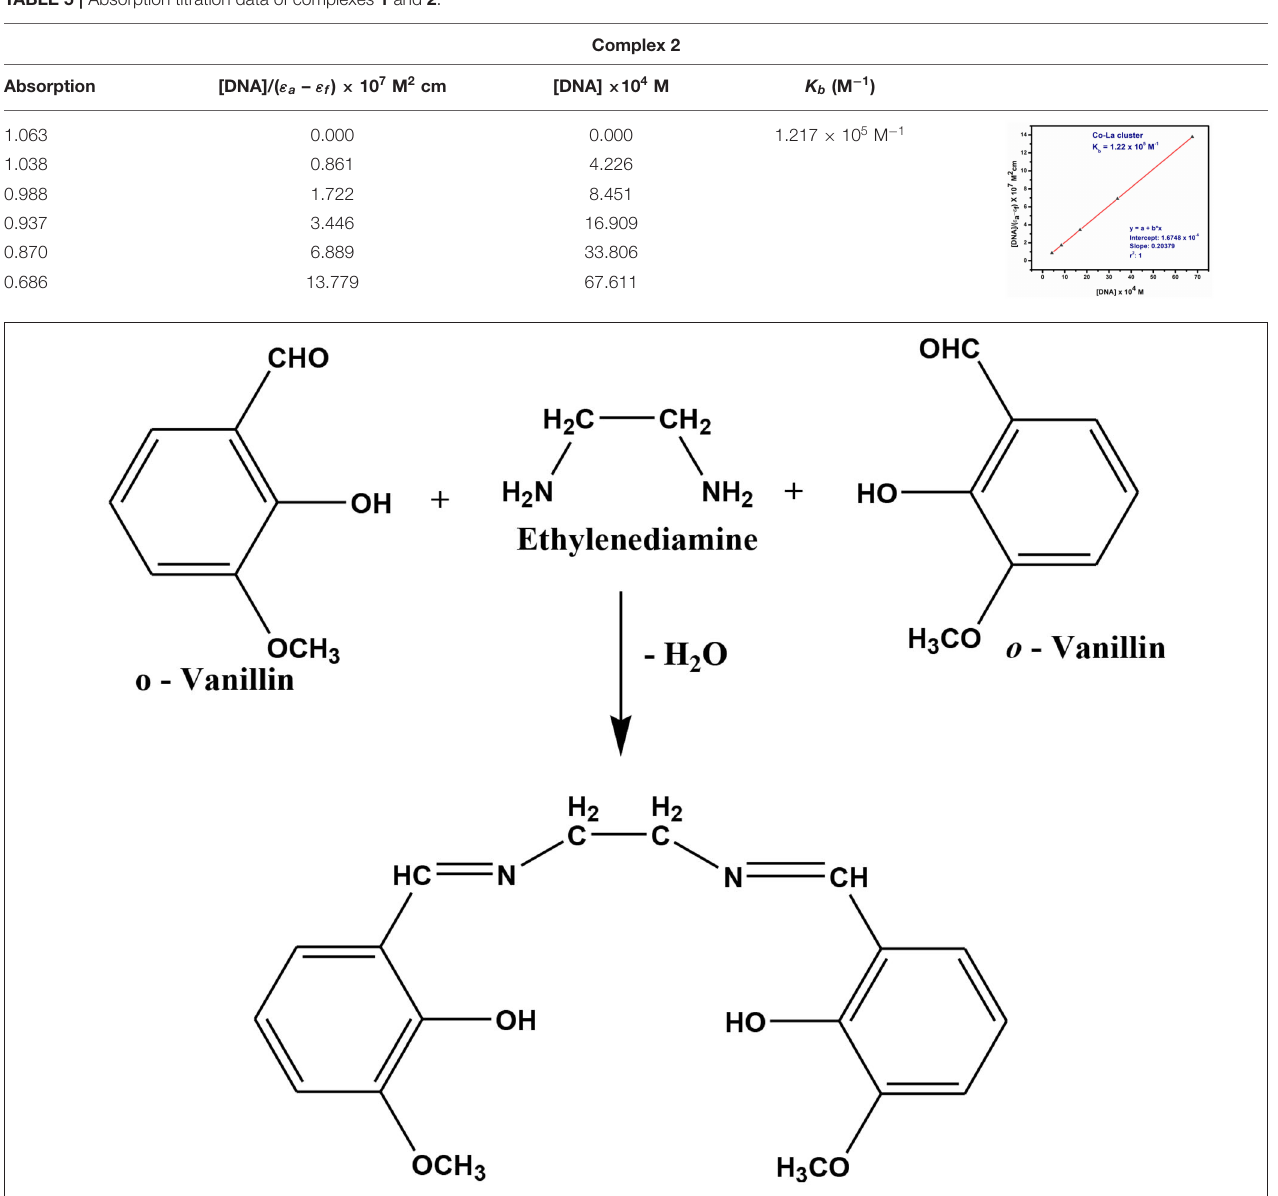
TABLE 5 | Absorption titration data of complexes 1 and 2